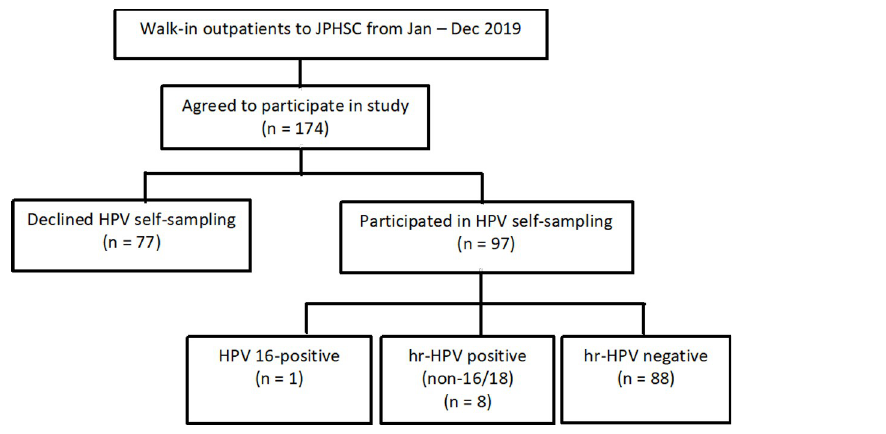
Fig 1. Flowchart of study participants at JPHSC, Brunei (Jan–Dec